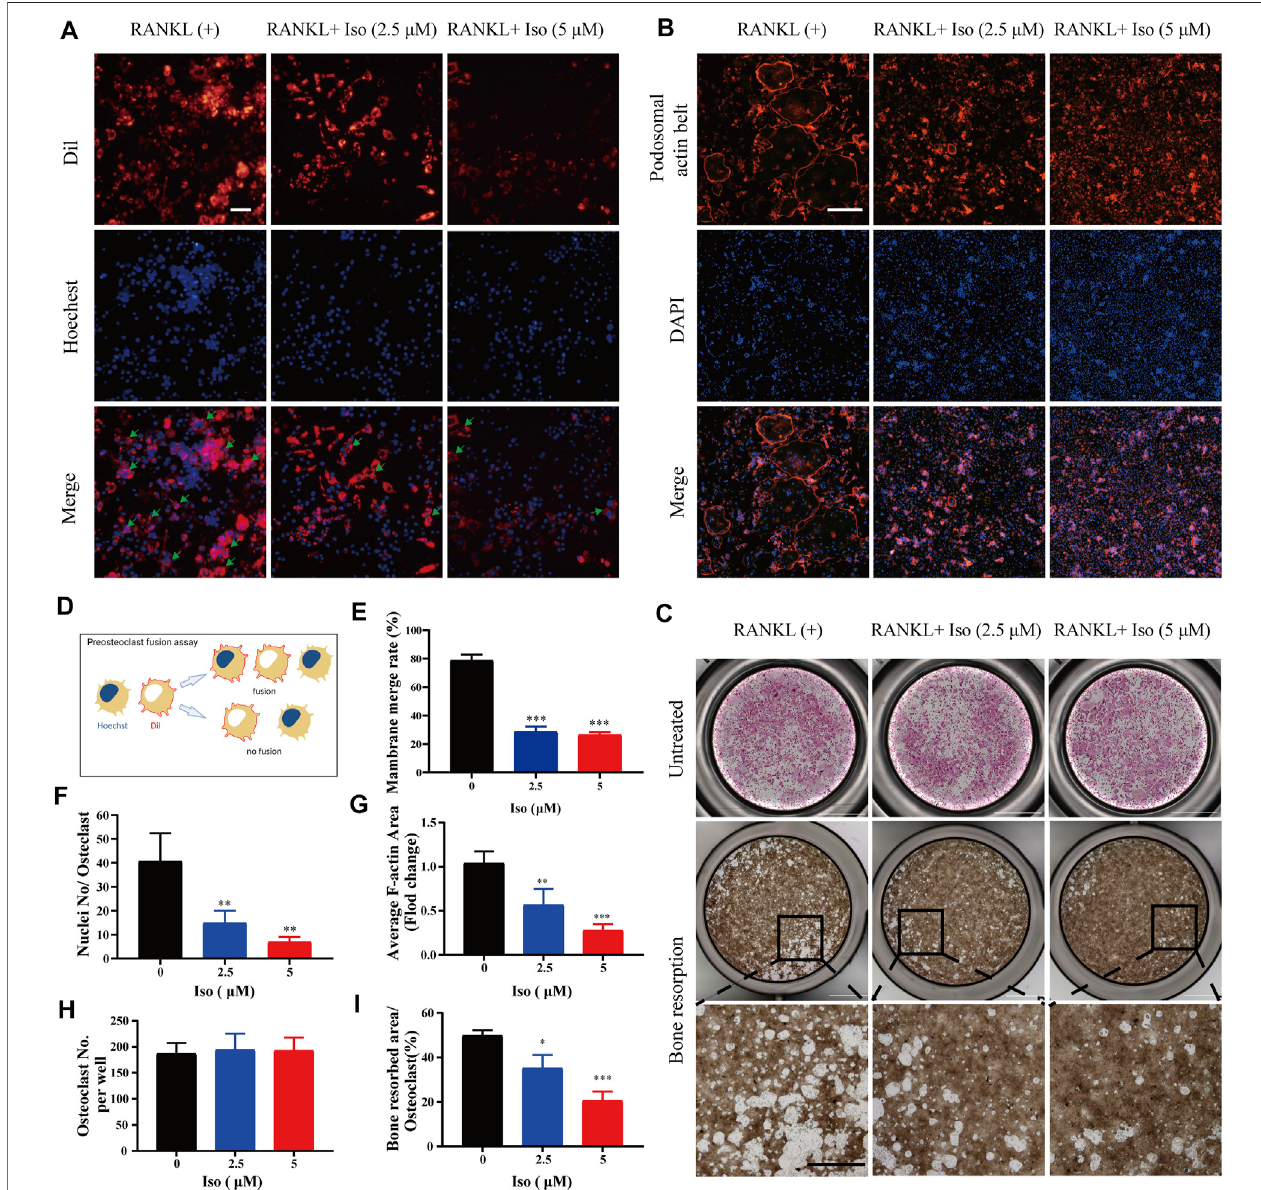
FIGURE 3 | Iso affects osteoclast fusion, F-actin belt formation and attenuates osteoclastic hydroxyapatite resorption triggered by RANKL. (A) Representative imagesofosteoclastfusiontreatedwithdifferentconcentrationsofIso(2.5 μ Mand5 μ M).Thecellmembrane(red)andnucleus(blue)ofosteoclastswerestained(scale= 100 μ M). (B) Representative images of podosomal belt formation in osteoclasts treated with different concentrations of Iso (2.5 μ M and 5 μ M). The actin cytoskeleton (red) and nucleus (blue) of osteoclasts were stained (scale = 400 μ M). (C) Representative micrographs of TRAP-stained osteoclasts (upper panels) and the assay surface after removal of osteoclasts on hydroxyapatite-coated plates with or without Iso (2.5 μ M and 5 μ M) (scale = 1000 μ M). (D) Process fl ows of osteoclast fusion assay (E) Double- fl uorescence BMMs fusion on day 3 quanti fi ed by the membrane merge rate (F) Numbers of nuclei per osteoclast ( n = 3). (G) Mean F-actin belt areas ( n =3). (H,I) TheTRAPpositivecellsandresorbedareaperwellwerequantitativelycountedwithImageJ( n =3).* p < 0.05,** p < 0.01,*** p < 0.001.Alldataareexpressed as mean ± SD. TRAP: tartrate-resistant acid phosphatase.